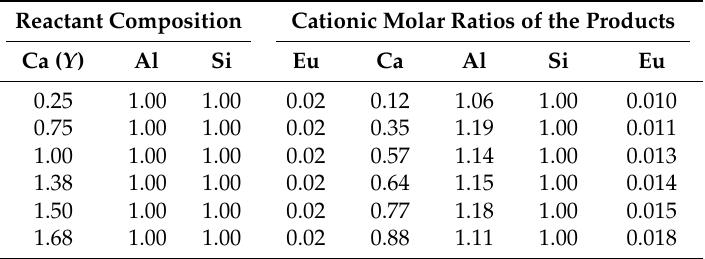
Table 1. ICP-OES (inductively coupled plasma optical emission spectrometry) analysis of cationic molar ratios of the products (synthesized with various Y ) after grinding and washing with an acid (also shown are the reactant compositions).